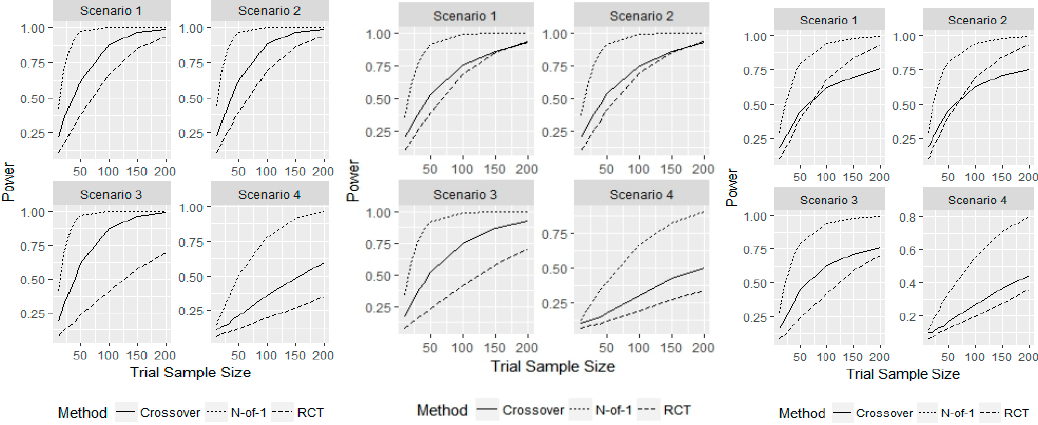
Figure 3. Simulation study for representative sample with a carryover effect size of 0.05 (left), 0.10 (middle) and 0.15 (right). Displays the power for detecting 𝜏 = 0.25 for given sample sizes and the three different designs considered.